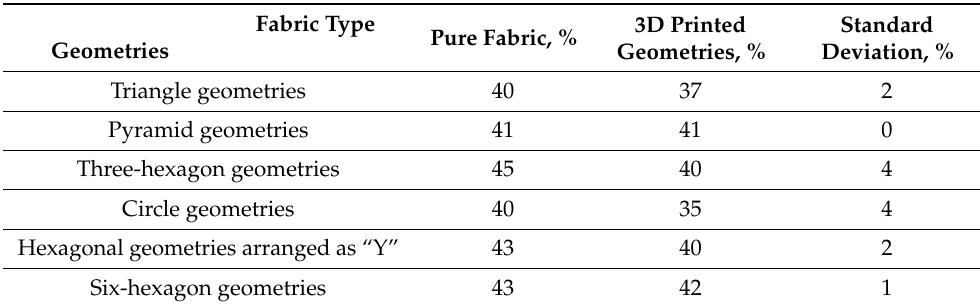
Table 3. The 3D printing drape parameters (DC, %).